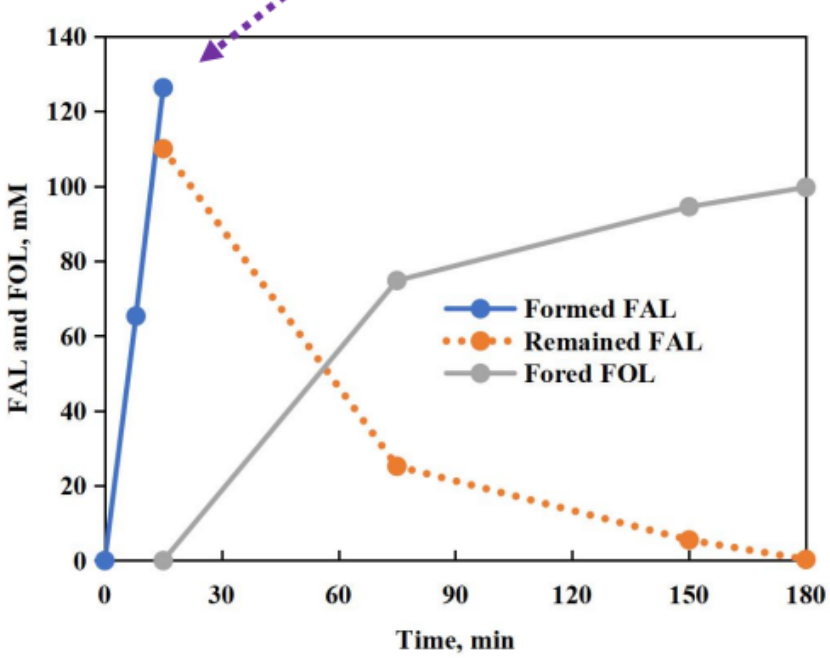
Figure 6. Tandem catalysis of corncob to FOL by bridging chemocatalysis with Sn-SSXR and bio-catalysis with CF cell in DES ChCl:LA–water (arrow: pH adjustment and CF cell addition).